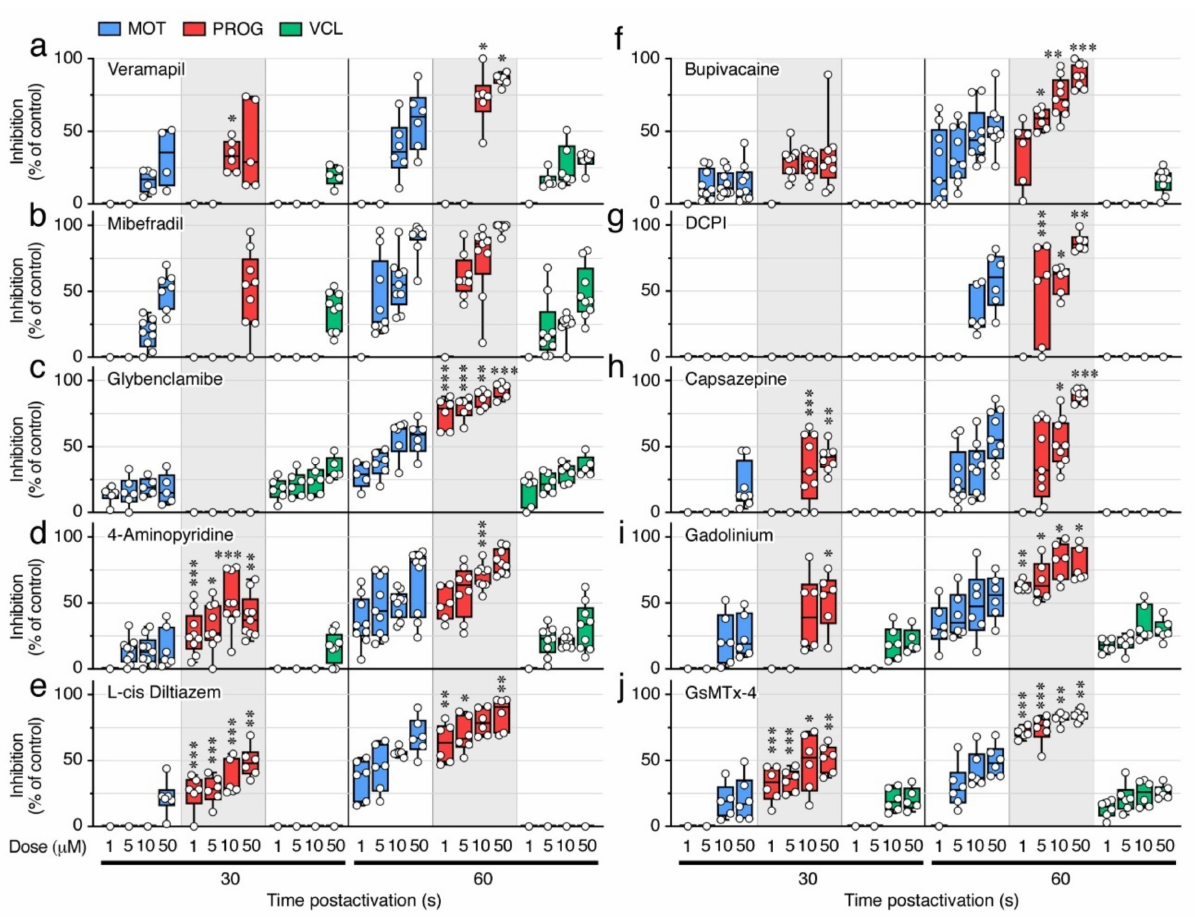
Figure 9. Percentage of inhibition of seabream sperm motility (MOT), progressivity (PROG), and curvilinear velocity (VCL), by the different ion channel blockers tested. ( a – j ) The percentage of inhibition at each dose and post activation time (30 or 60 s) with respect to DMSO-treated spermatozoa was calculated from data shown in Figures 7 and 8. In all panels, the data points ( n = 6–8 males, one ejaculated per male) are presented as box and whisker plots/scatter dots with horizontal line (inside box) indicating median and outliers. The asterisks indicate statistical differences between the percentage of inhibition of PROG and MOT at the same dose and post activation time (Student t -test; *, p < 0.05; **, p < 0.01; ***, p <